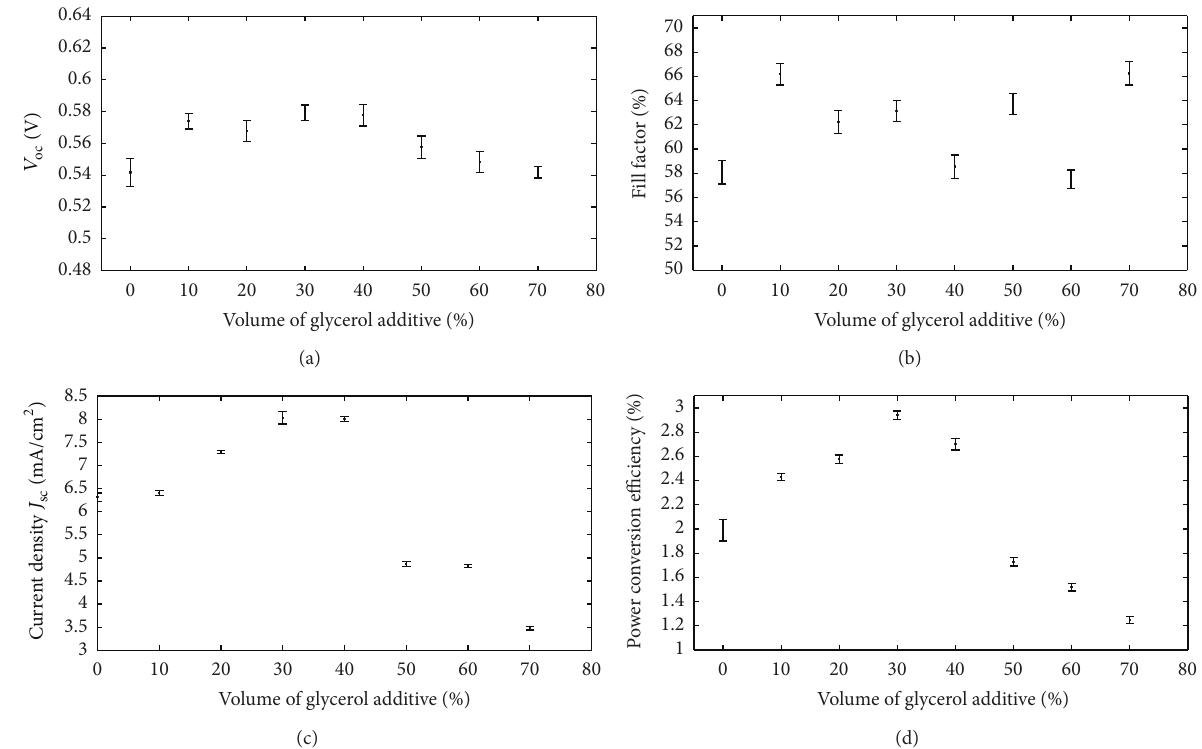
Figure 2: The average variation of photovoltaic parameters with different glycerol concentrations in the active layer.